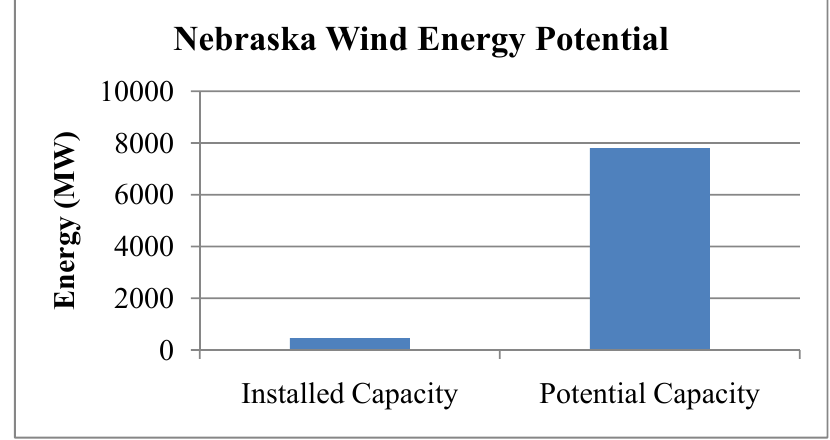
Figure 1. A comparison of installed capacity and potential wind energy in the State of Nebraska, U.S., as of 30 September